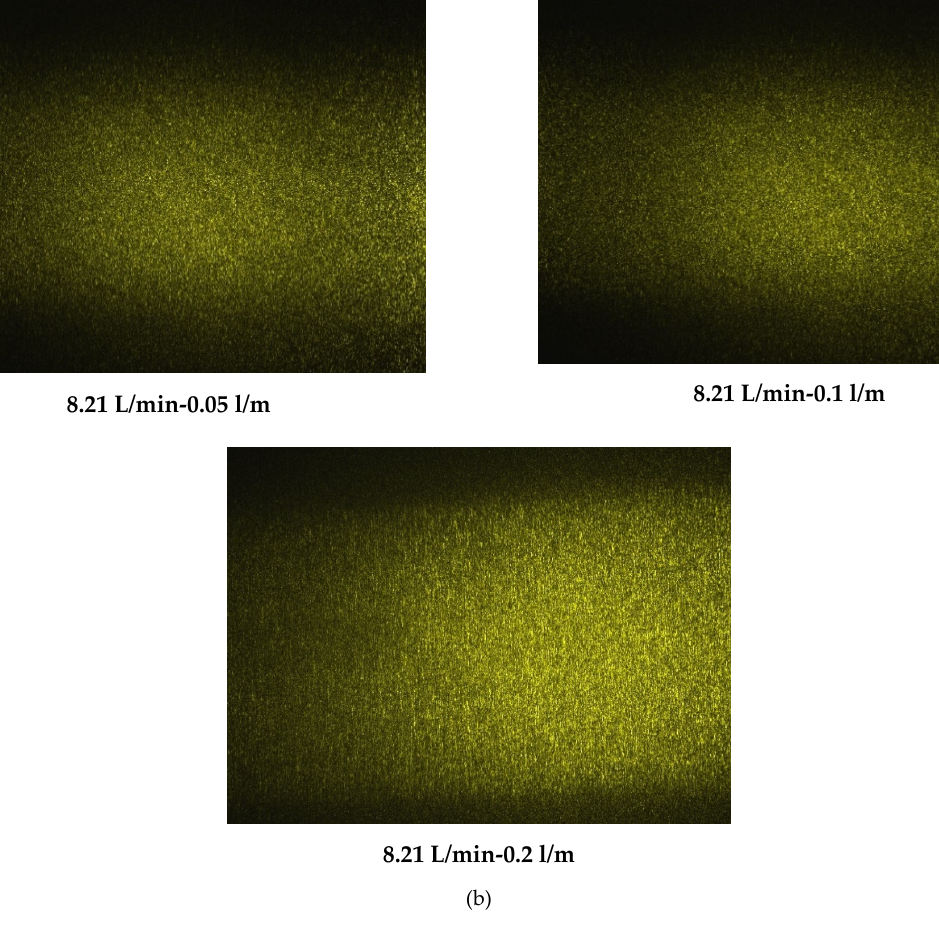
Figure 6. ( a ) Distribution of bubble diameters at different air volume flow rate (water flow rate = 8.21 L/min) (experimental and CFD). Average diameter: 0.05 L/min ‐ 64.8 μ m (CFD), 0.1 L/min ‐ 64.9 μ m (CFD), 0.2 L/min ‐ 63.9 μ m (CFD), 0.05 L/min ‐ 45.6 μ m (Exp.), 0.1 L/min ‐ 57.7 μ m (Exp.), 0.2 L/min ‐ 65.1 μ m (Exp.). (Throat Reynolds number (Re) = 62,200); ( b ) The images from experimental measurements for water flow rate of 8.21 L/min and different air flow rates (0.05 L/min, 0.1 L/min, 0.2 L/min).